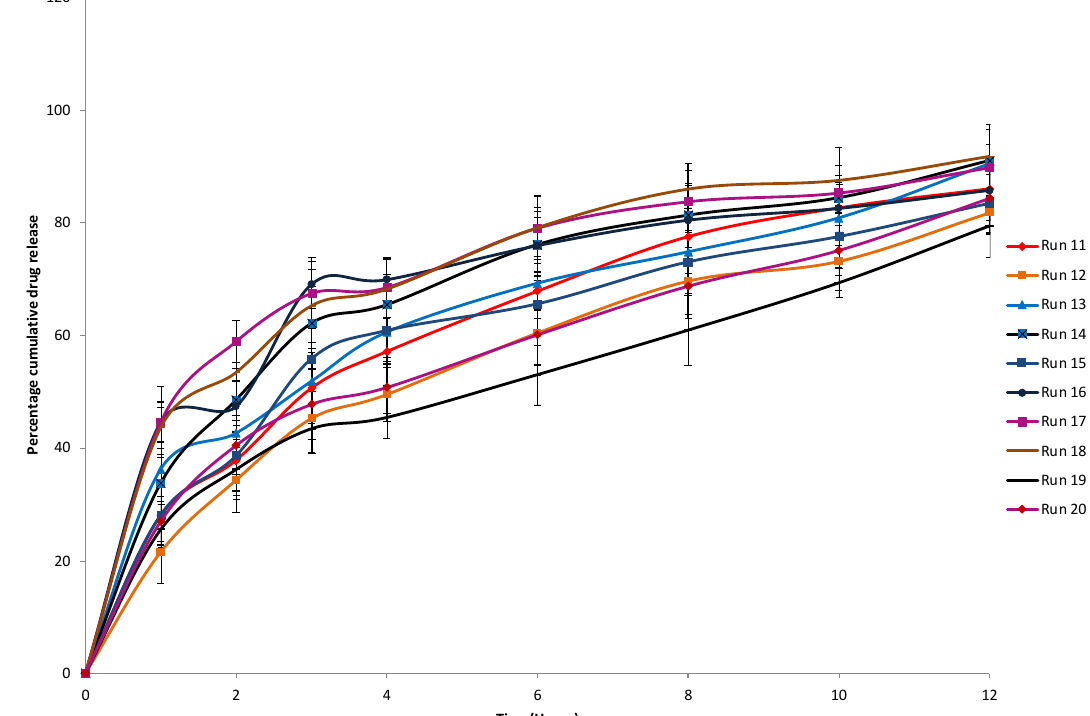
FIGURE 6 - In-vitro drug release for run 11-run 20 suggested by